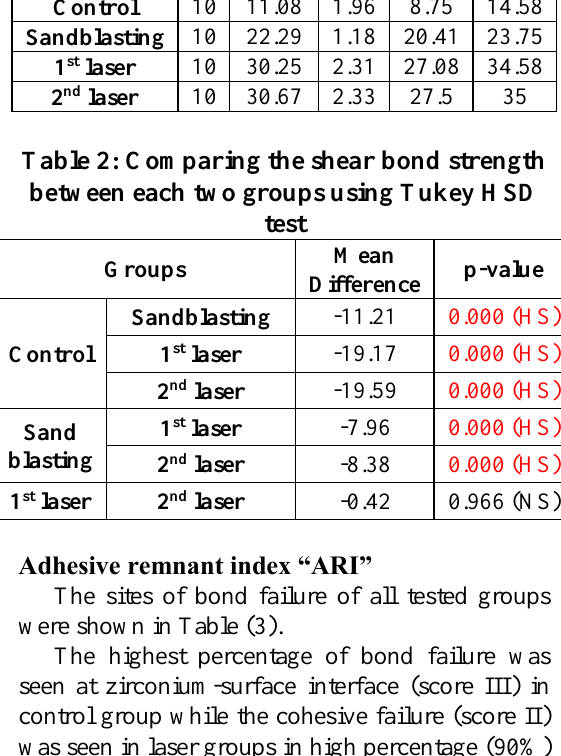
Table 1: Descriptive statistics of the shear bond strength (MPa) Groups